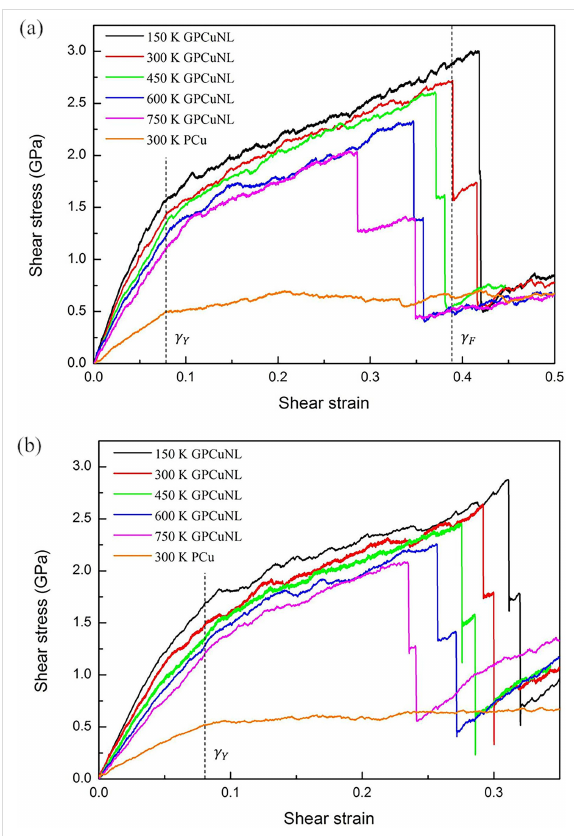
Figure 3: Stress–strain curves of (a) zigzag and (b) armchair GPCuNL composites at different temperatures.